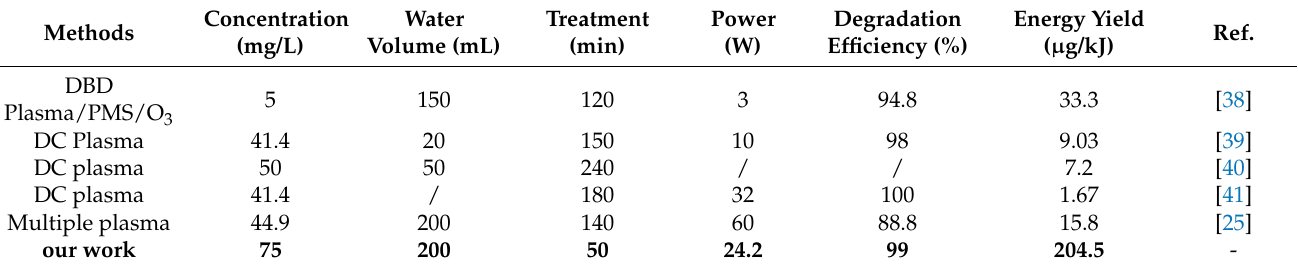
Table 2. Comparison of energy yields in various treatment processes.